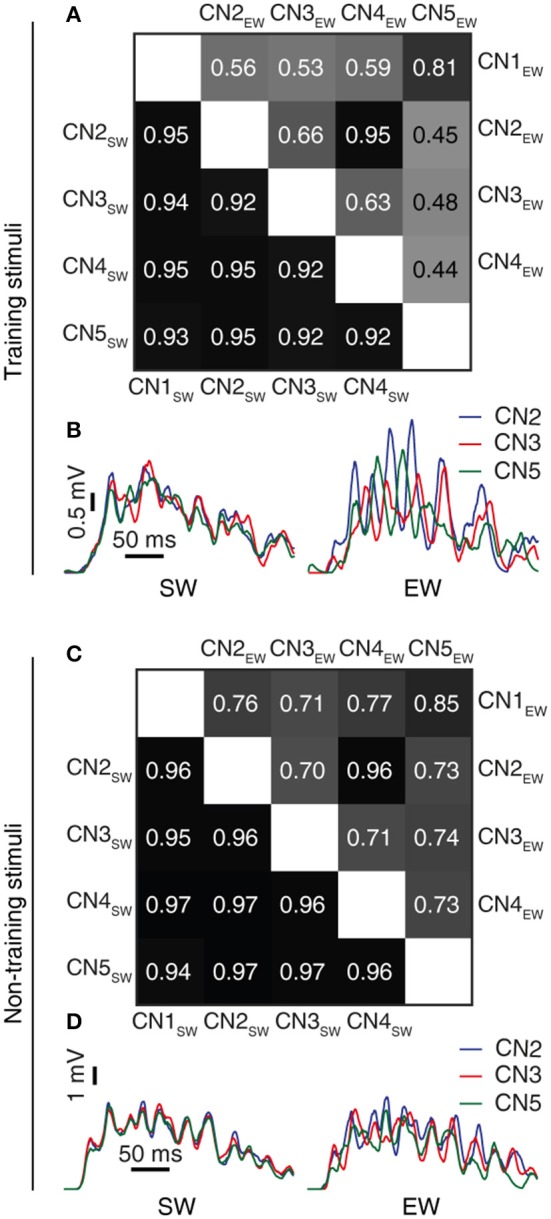
Learning resulted in decorrelated responses between neurons to the same stimulus. (A) Triangle matrix for the correlations between synaptic responses evoked by the same training stimulus before (CN1SW-CN5SW) and after learning for all five cuneate neurons (CN1EW-CN5EW). The difference in correlation between the two groups was statistically significant (p = 0.001, Wilcoxon signed rank test) (B) Averaged synaptic responses to the stimulus (‘indentation 20 mm') repeated 100 times for three different CNs (CN2, CN3, CN5) before and after training. (C,D) Similar displays as in (A,B) but for a novel stimulus that was not part of the training set (“indentation 10 mm;” Oddo et al., 2017). The difference in correlation before and after learning was statistically significant (p < 0.001, Wilcoxon signed rank test).